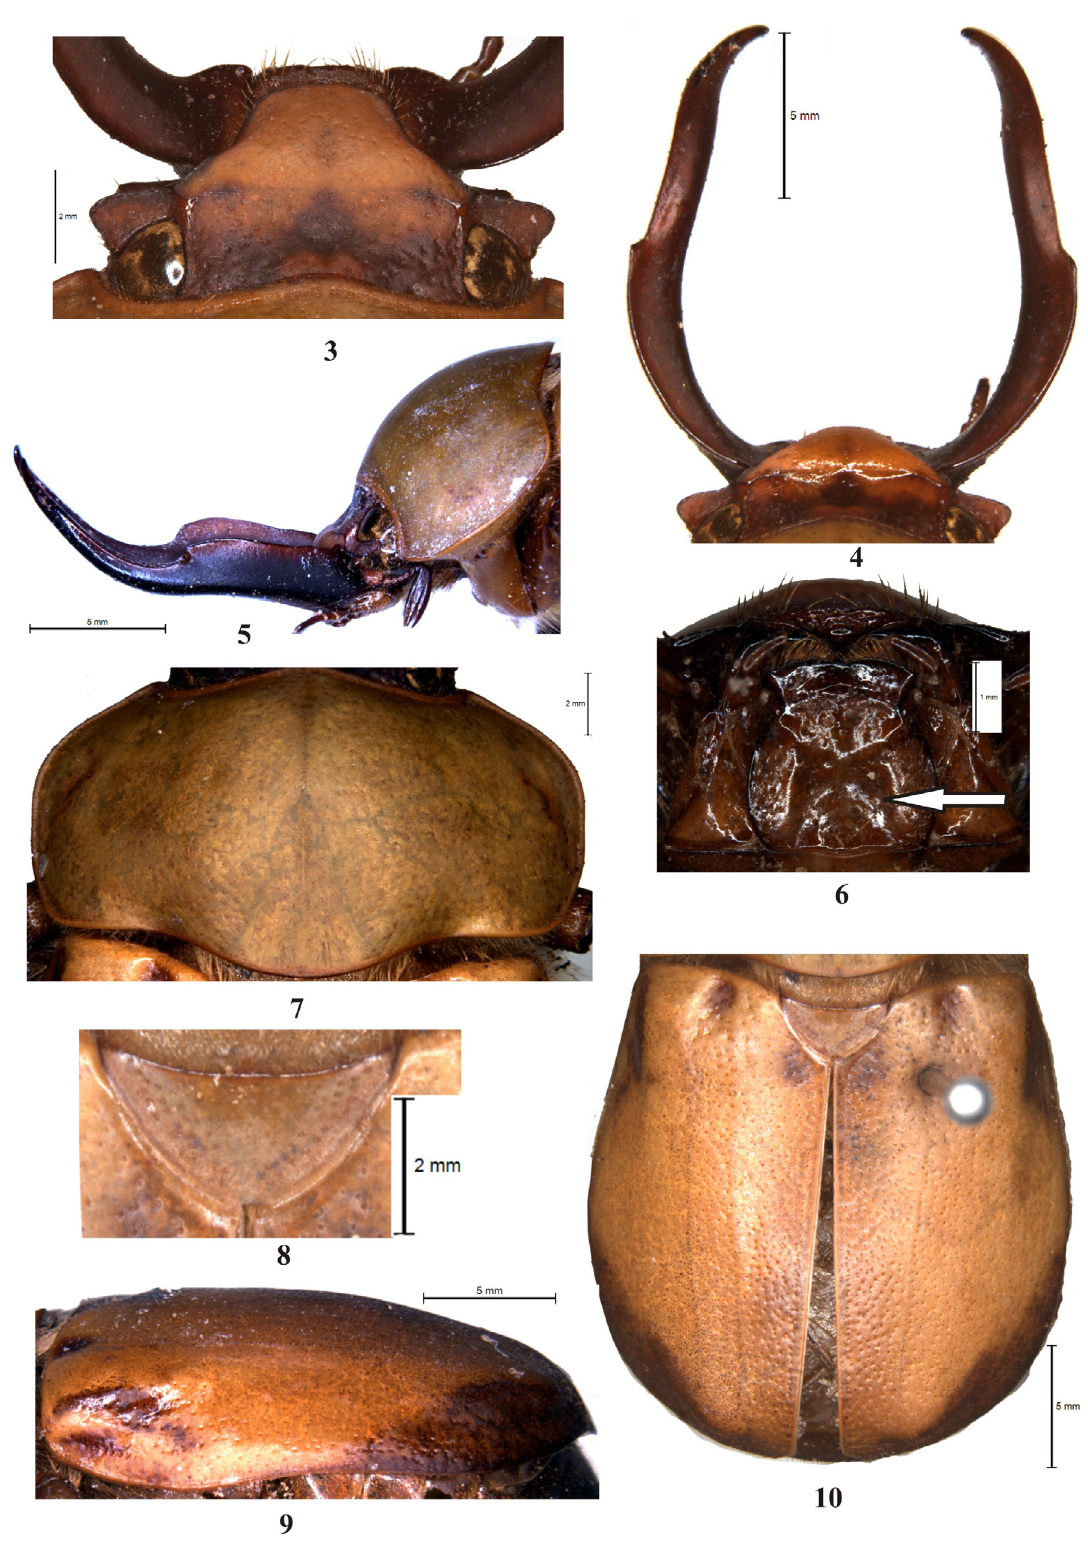
Figs 3–10. Pukupuku arunachalensis sp. nov., holotype, ♂. 3 . Clypeus. 4 . Mandibular horns (dorsal view). 5 . Mandibular horns (lateral view). 6 . Mentum (arrow indicates the character separating Pukupuku from the closely related genera). 7 . Pronotum. 8 . Scutellar plate. 9 . Right elytron (dorsal view). 10